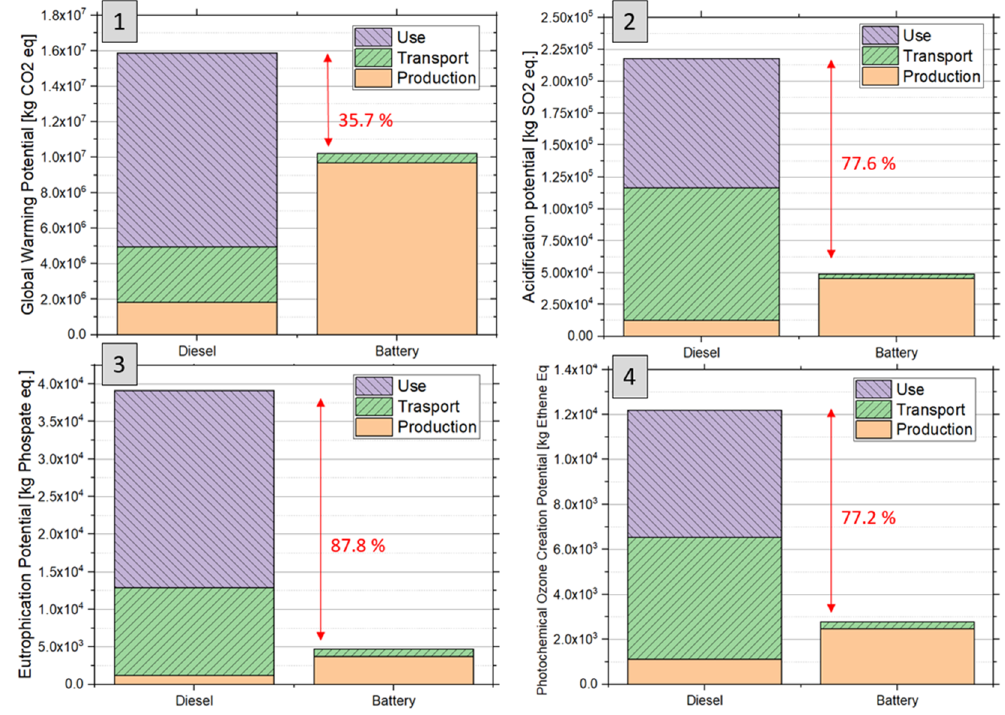
Figure 13. Results of life cycle assessment: ( 1 ) GWP, ( 2 ) AP, ( 3 ) EP and ( 4 ) POCP.